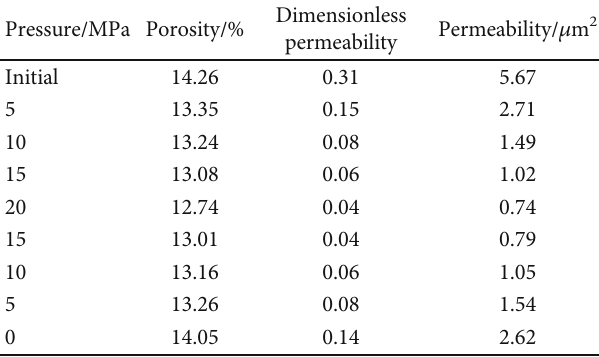
Figure 4: The images of streamlines in the fractured-porous sample. Table 1: LBM-simulated permeability data for fractured-porous sample.